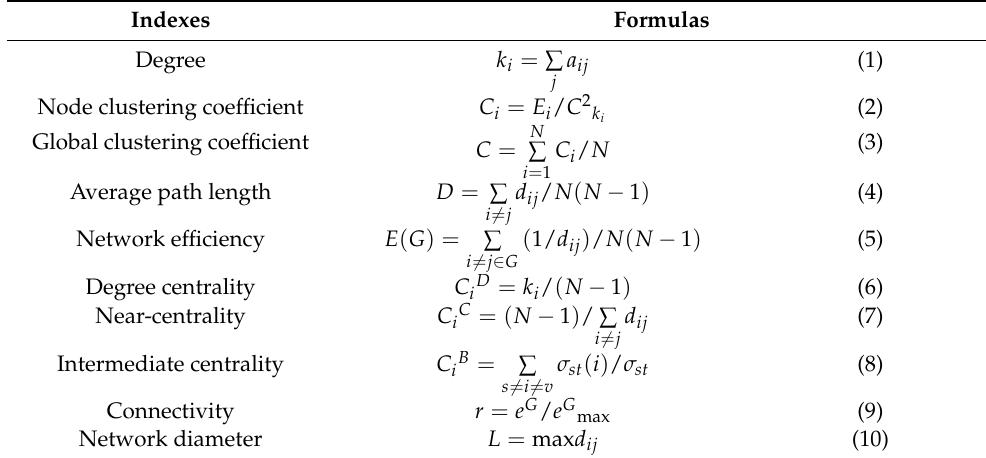
Table 1. Formulas for calculating static